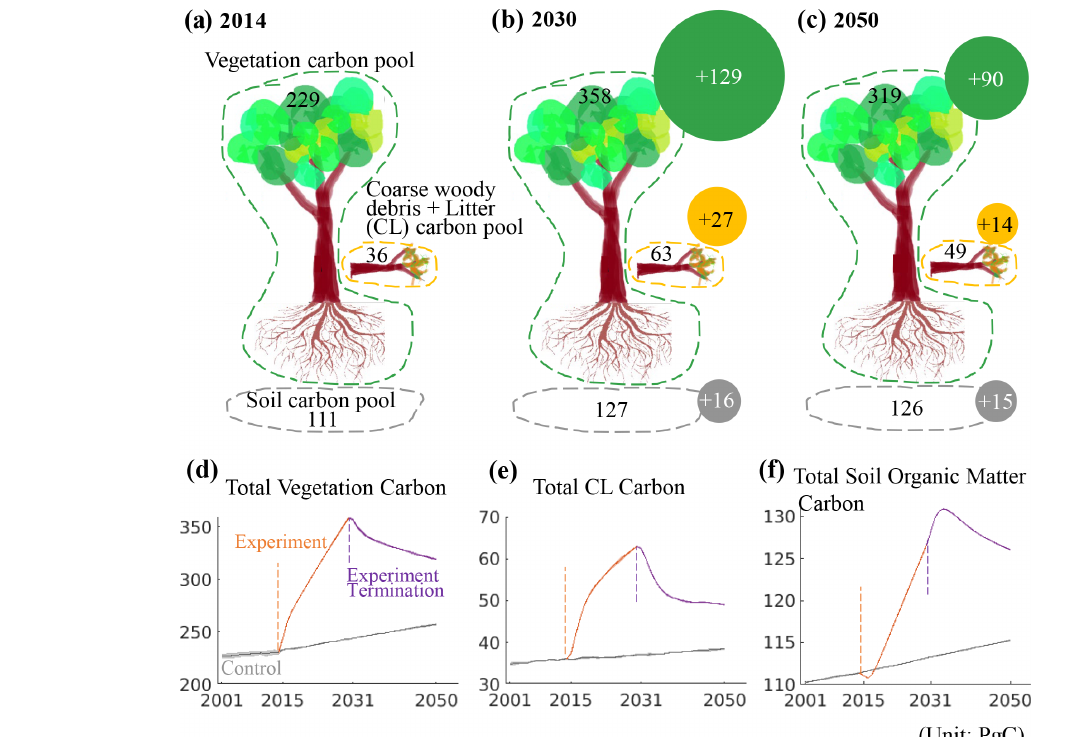
Figure 3. Where did the net absorbed carbon go? Global tropical forest carbon amount responses. (a) The current carbon amount in different carbon pools. (b) Carbon amount in 2030 after 16-year lighting experiments. (c) Carbon amount in 2050 after 20 years since the termination of the lighting experiments. The solid circles in panels (b) and (c) refer to carbon amount changes with respect to panel (a) . The numbers in panels (a) – (c) are based on panels (d) – (f) . Tree drawing courtesy of © Ning